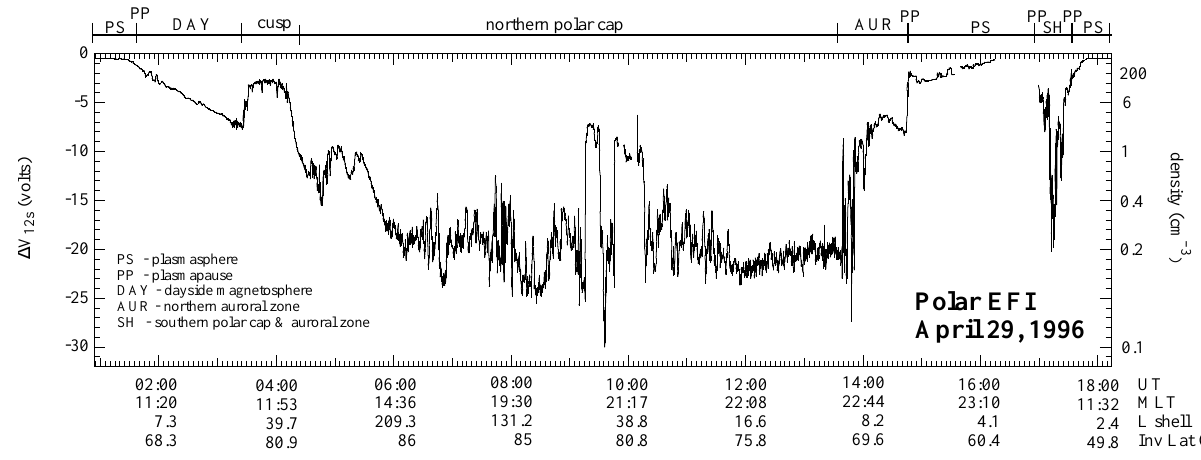
Fig. 2. Negative spacecraft potential ( 1V 12 s ) measurements of the Polar EFI instrument during one orbit on 29 April 1996, when the Polar’s orbital plane was near to the midnight-noon meridional plane (for the orbit, see Fig. 1). The right-hand side presents the approximate plasma